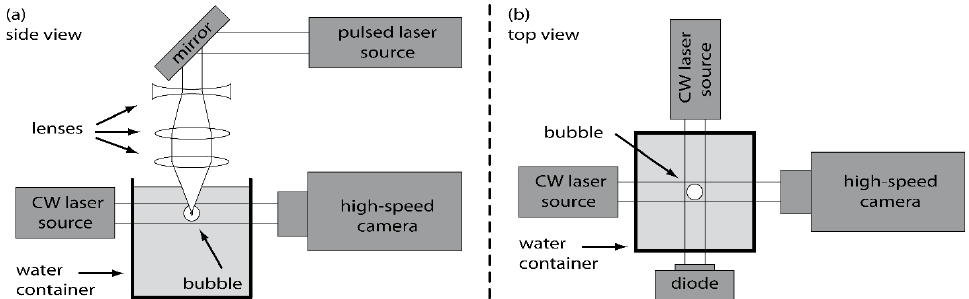
Figure 1. Experimental setup: ( a ) Side view: Pulsed laser, and high-speed camera and backlit illu- mination laser, ( b ) Top view: laser-photodiode synchronization system, and high-speed camera and backlit illumination laser.